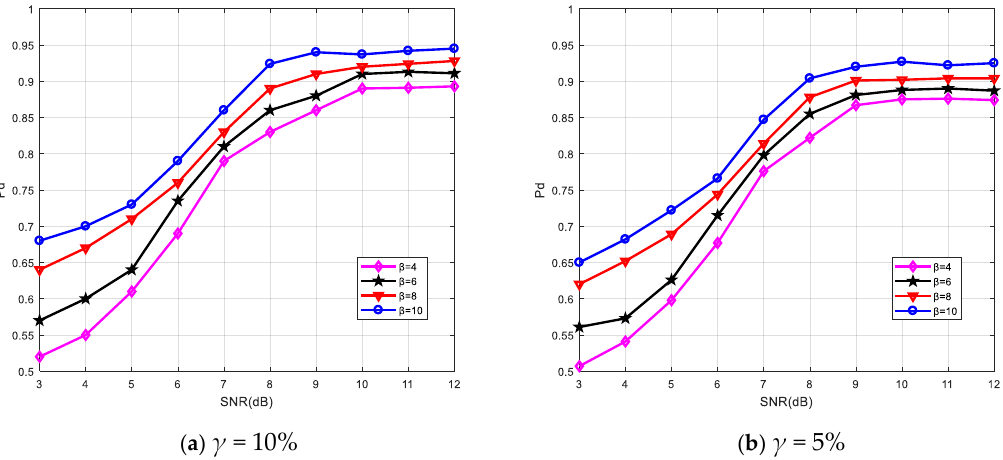
Figure 6. Performance of the TOA estimation.